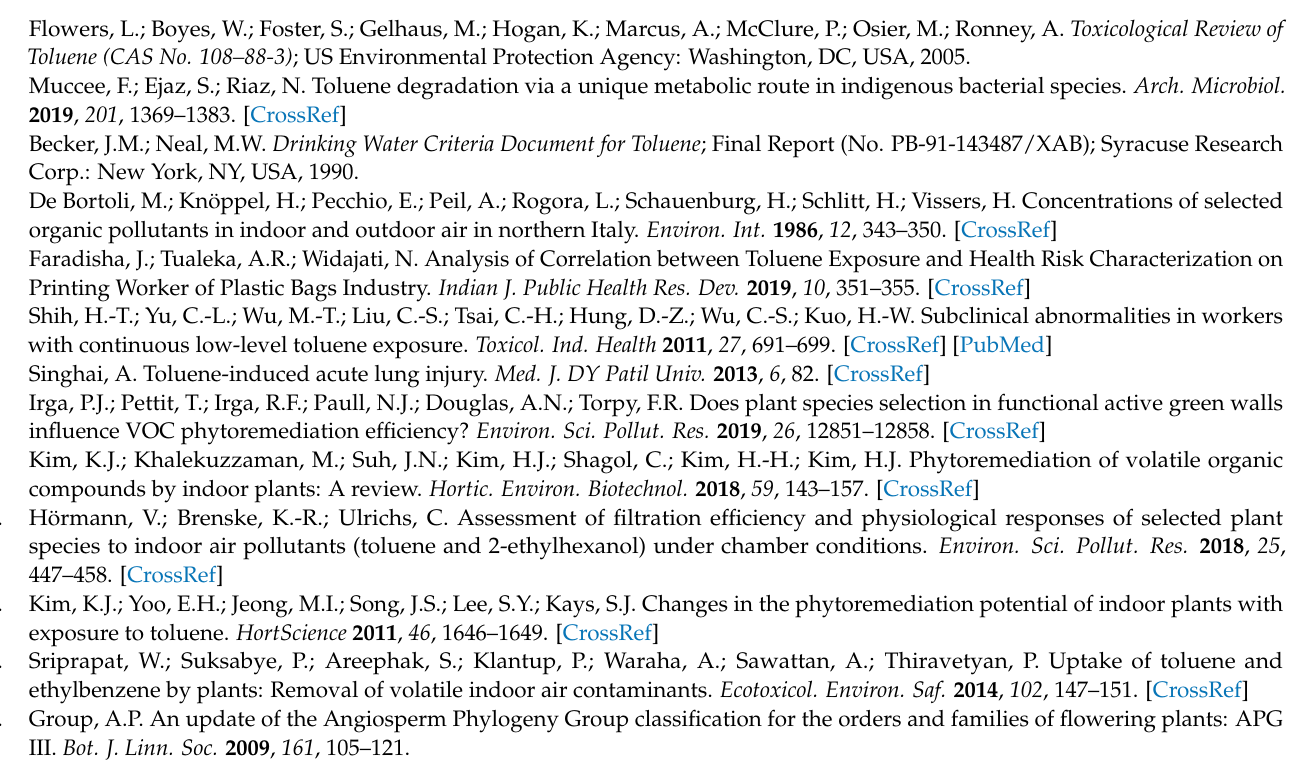
Figure S3: KEGG analysis DEGs in endocytosis after toluene treatment in A. pusilla , Table S1: Primer sequences for metabolic pathways and reference genes used in this study, Table S2: Assembly statistics and statistics of clustered contigs (unigene) in A. pusilla leaf transcriptome, Table S3